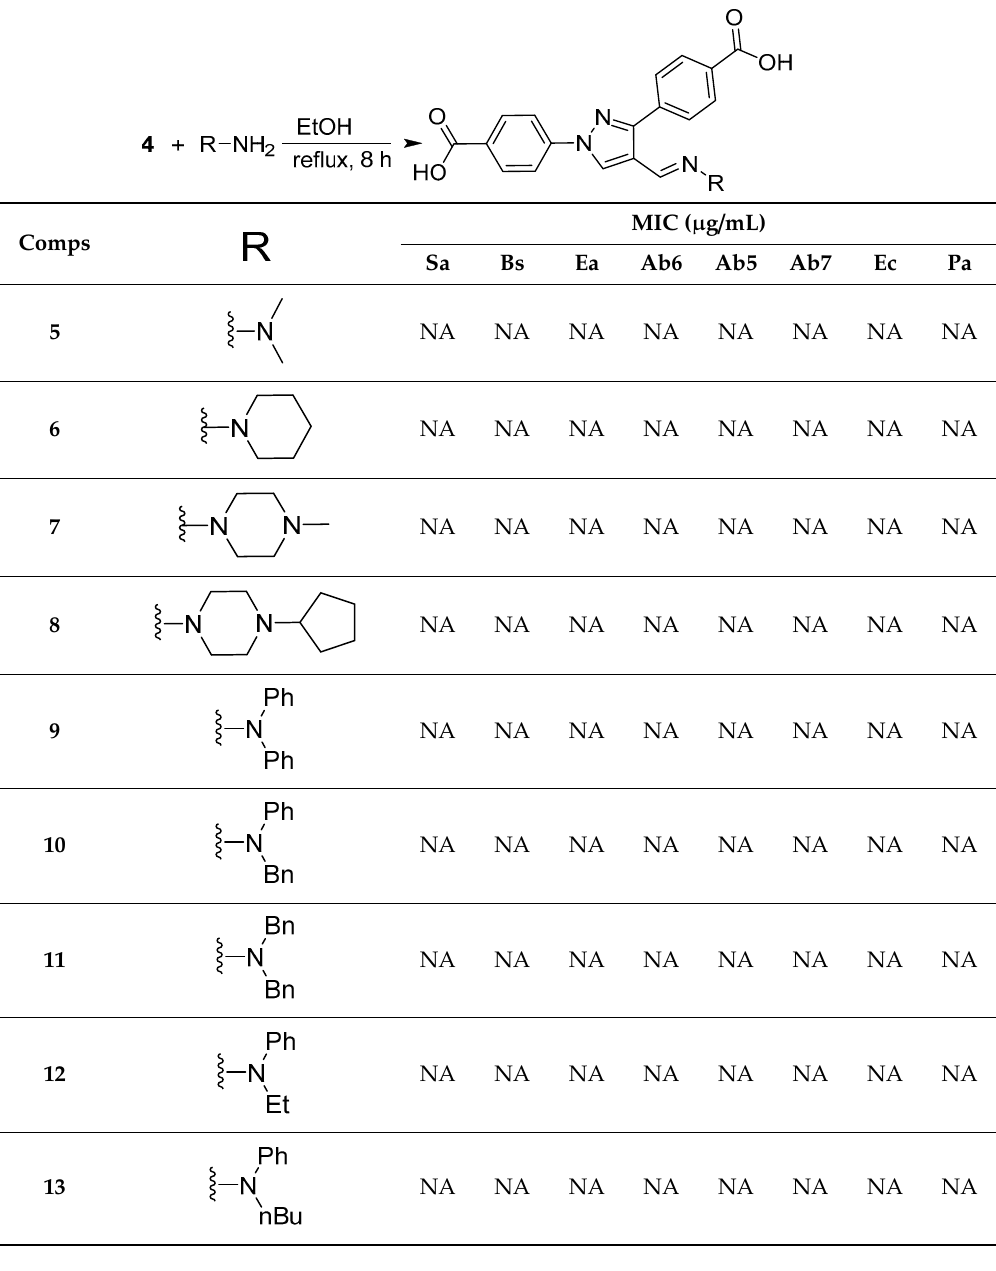
Table 1. Synthesis and antimicrobial activity of (pyrazole-1,3-diyl)dibenzoic acid substituted hydrazone derivatives.